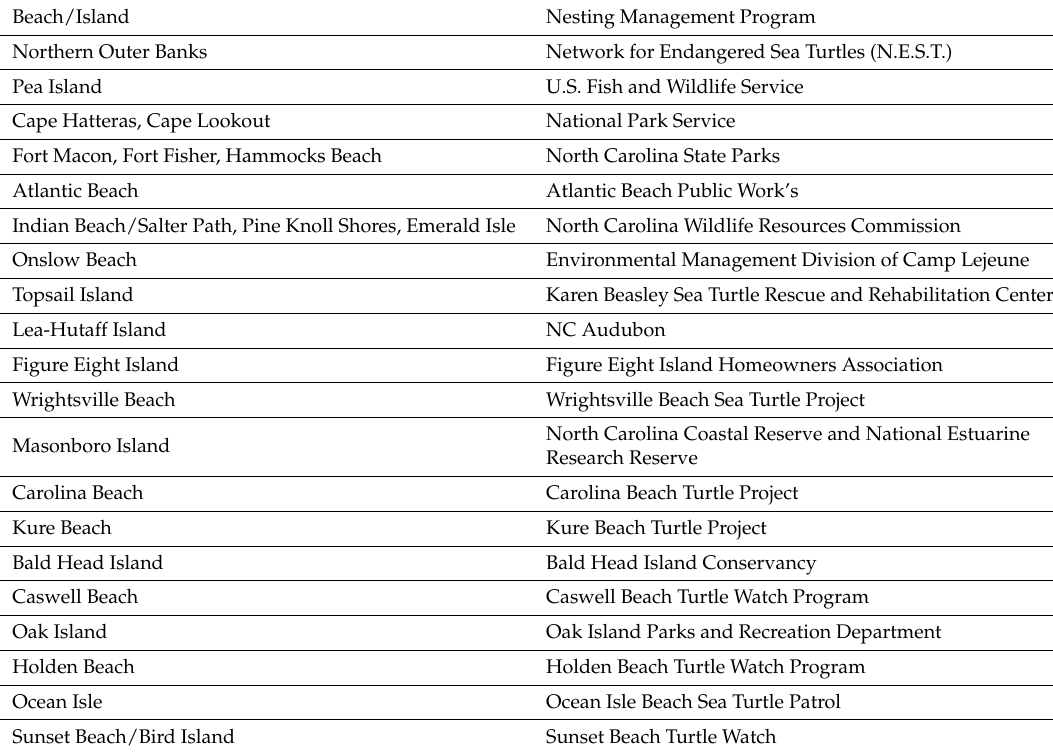
Table A1. Sea Turtle Nesting Management Programs in North Carolina, USA.